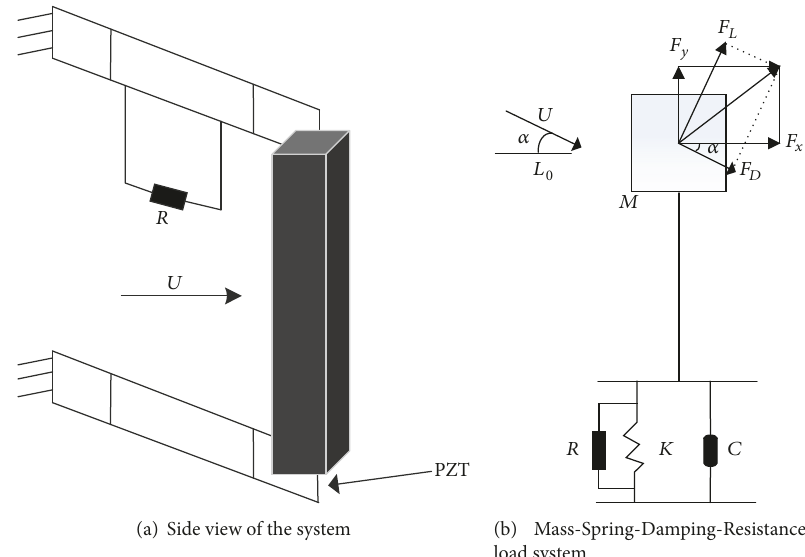
Figure 1: Physical model of square column energy harvesting